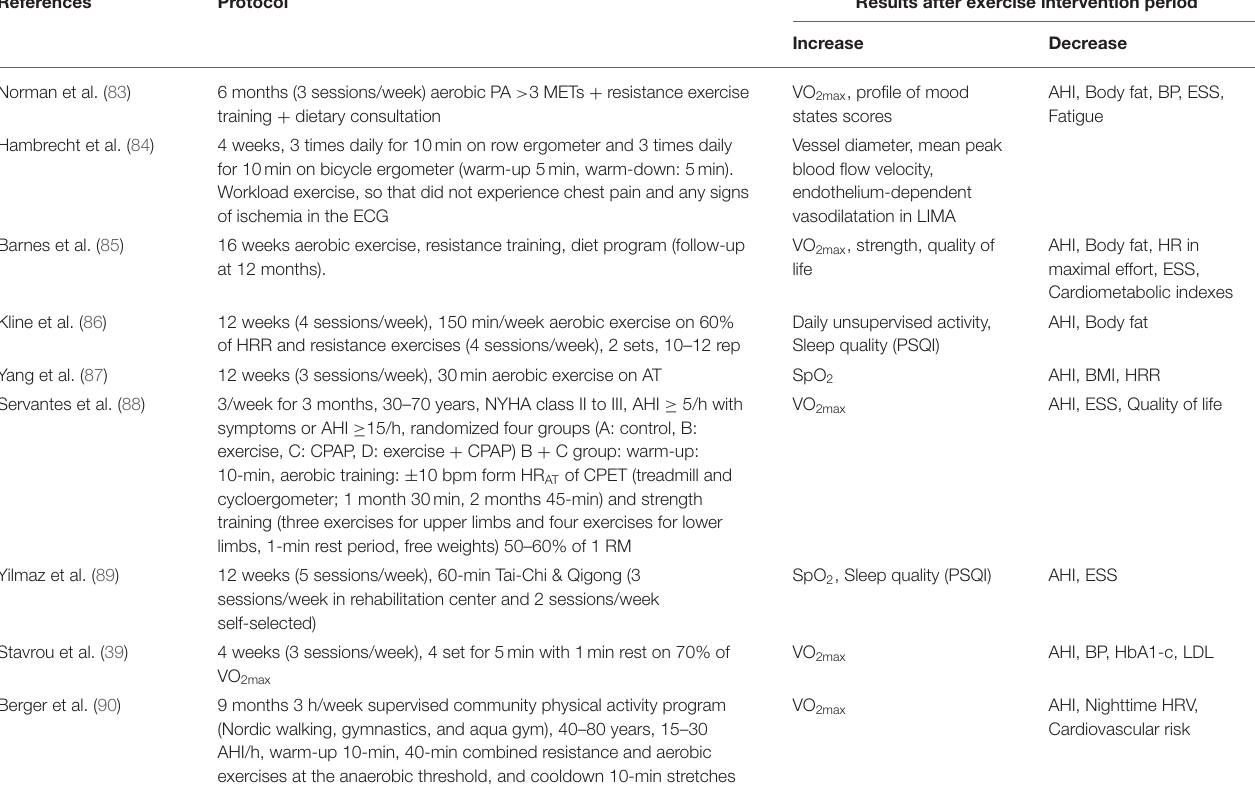
TABLE 3 | Chronic responses to exercise in patients with